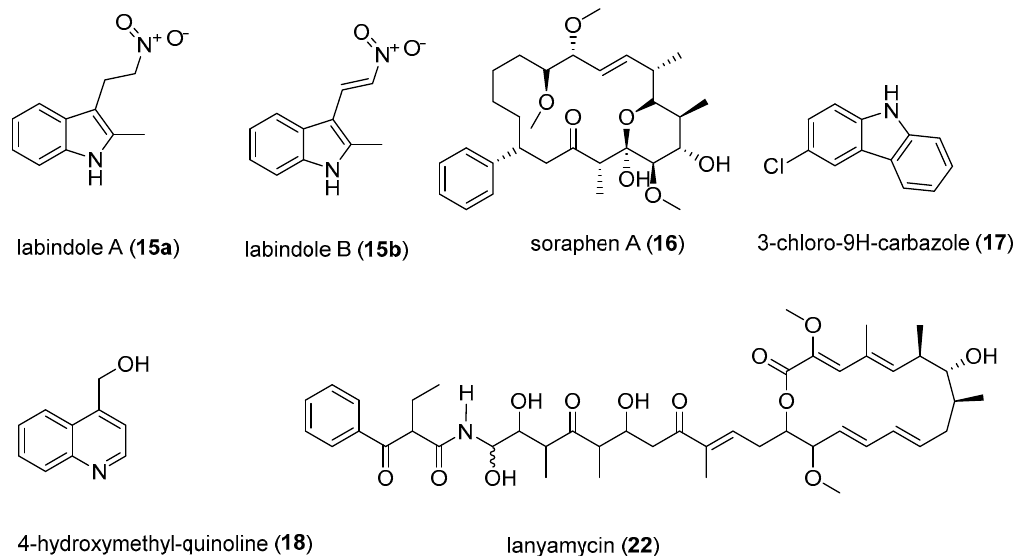
Figure 6. Compounds with activity against Hepatitis C Virus.